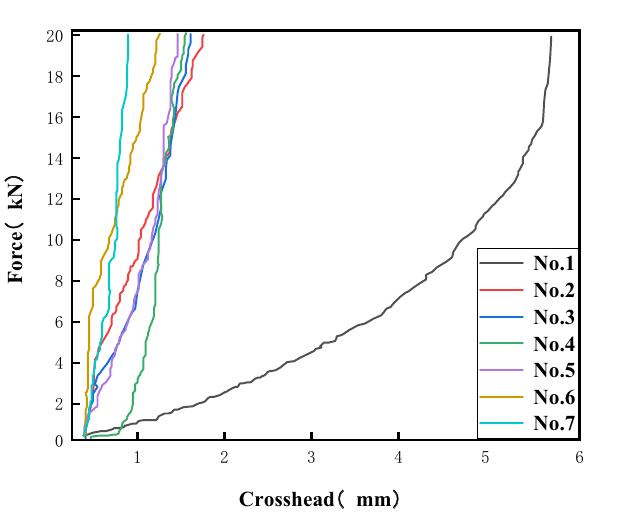
Figure 11. Compression test